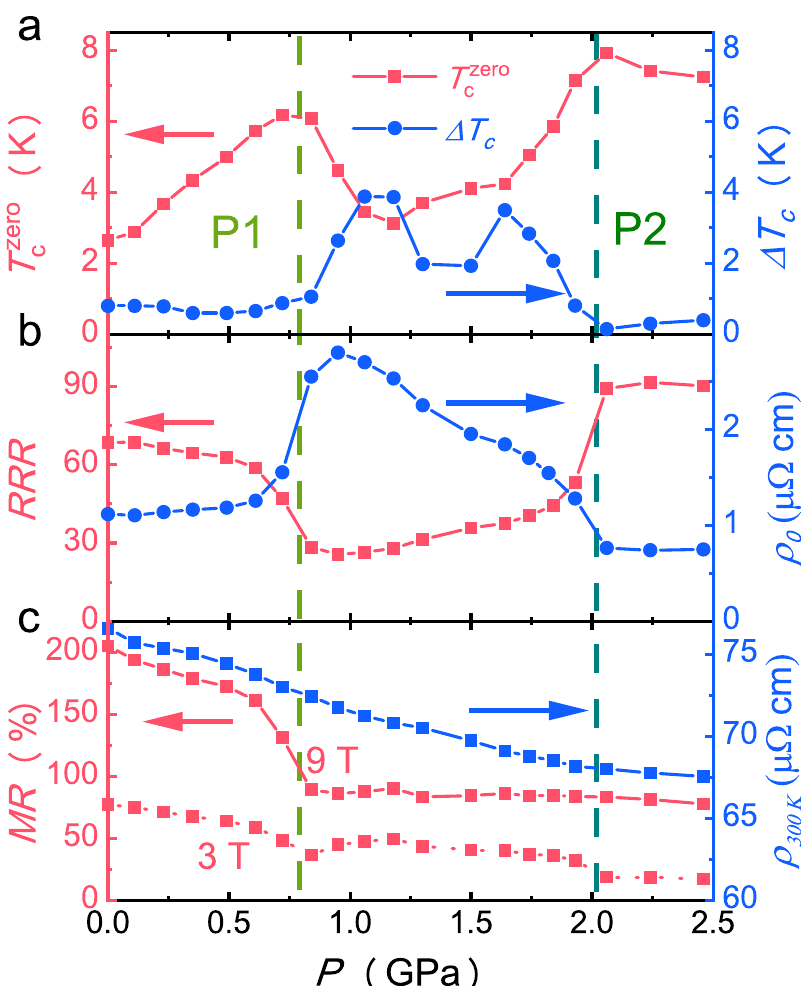
Fig. 4 Pressure dependence of residual resistivity, residual-resistivity ratio and magnetoresistance for CsV 3 Sb 5 single crystal. a Pressure dependence of T zero c and Δ T c for sample 1 with PCC. T zero c exhibits two peaks at P1 and P2. b Pressure dependence of residual resistivity and residual resistivity ratio (RRR) for sample 1 with PCC. c Pressure dependence of magnetoresistance (9 T and 3 T, 10 K) and room-temperature